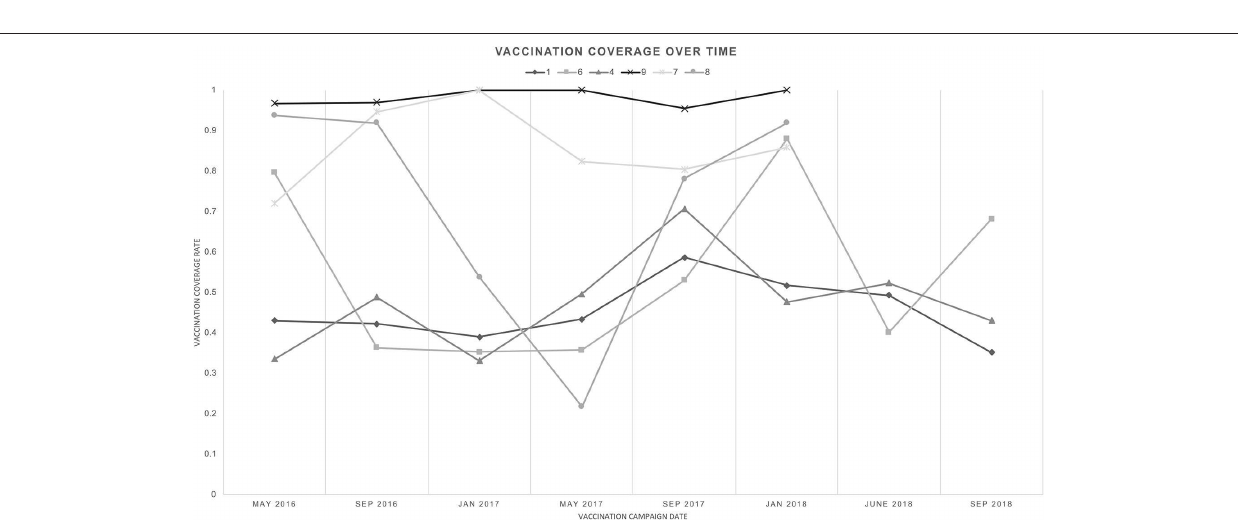
FIGURE 4 | Vaccine coverage over time, across pilot communities—The community vaccination percentage at each time point for each community is